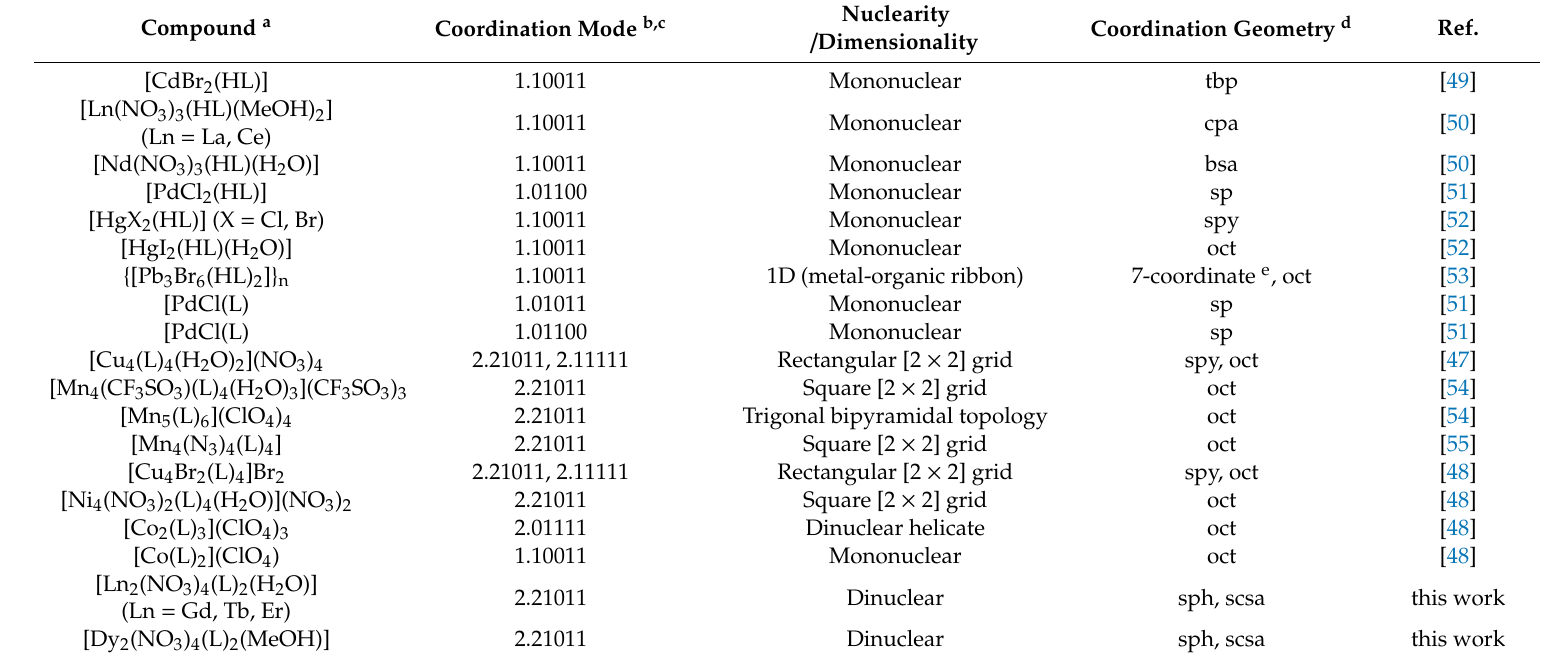
Table 3. To date crystallographically characterized metal complexes of HL and L¯, and relevant structural